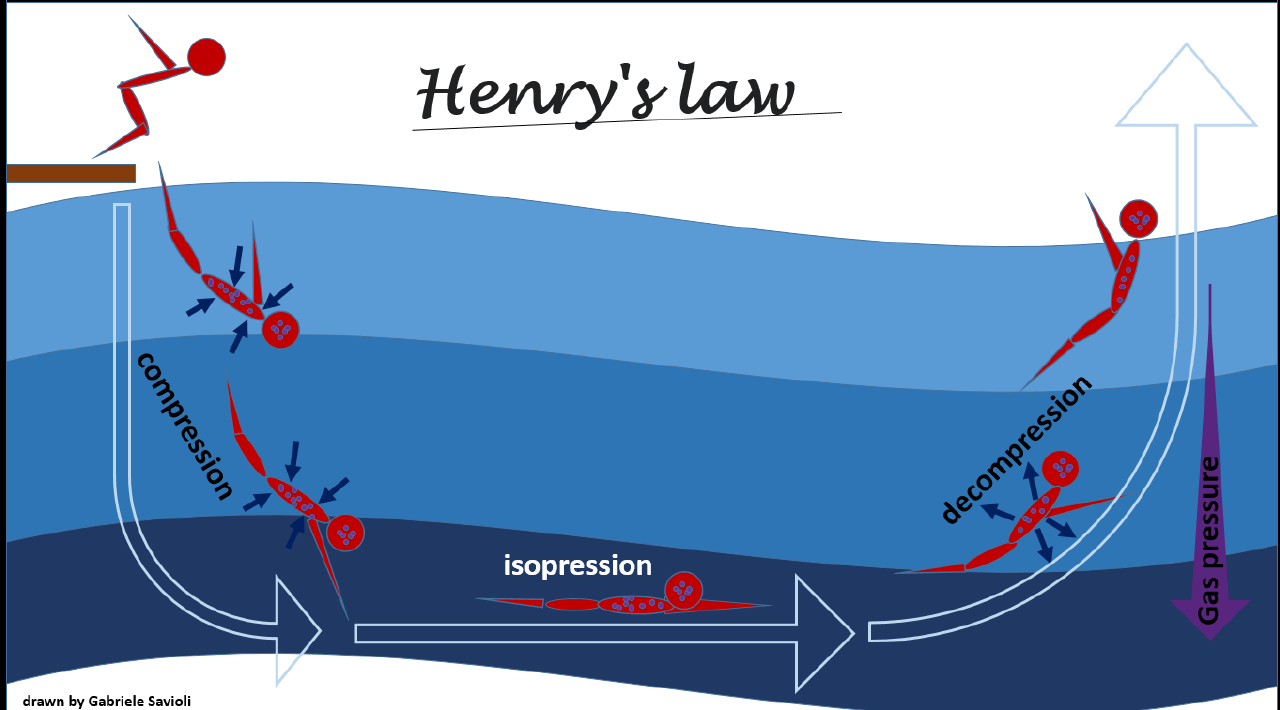
Figure 1. Henry’s law.